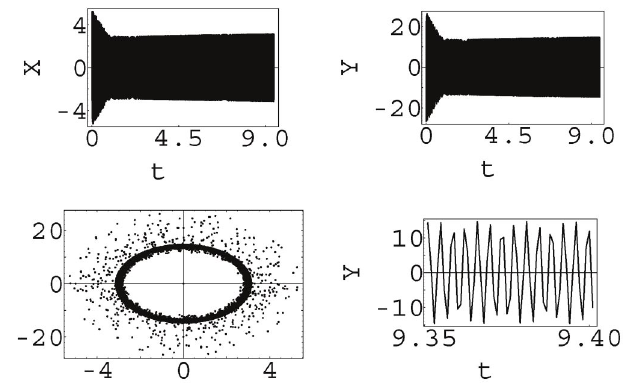
FIG. 6. Trajectories x (cid:6) t (cid:7) and y (cid:6) t (cid:7) of 5 (cid:3) m Ti particle for BEPC parameters vs time in seconds. Initial conditions x (cid:6) 0 (cid:7) (cid:8) 3 : 0 , (cid:6) 0 (cid:7) (cid:8) 0 , y (cid:6) 0 (cid:7) (cid:8) 0 : 0 , v (cid:6) 0 (cid:7) (cid:8) 6 : 56 m = s , T (cid:8) 1500 K , Q p x y 10 8 . The bottom row shows the trajectory in the (cid:6) x; y (cid:7) plane and the zoomed part of the trajectory for the last 50 ms of